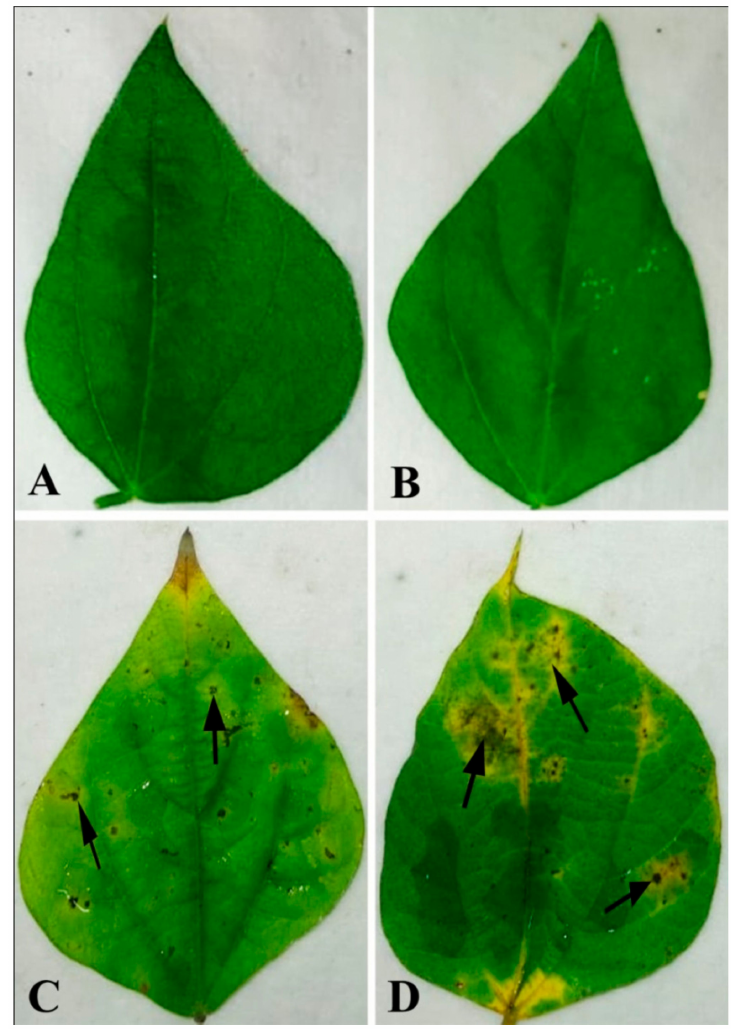
Figure 1. Pathogenicity test on bean leaf. Water-treated control showing no symptoms after ( a ) 2 dai and ( b ) 4 dai. Leaves treated with conidial suspension showing infection zones after ( c ) 2 dai and ( d ) 4 dai. Arrows indicate the site of pathogen infection. Note: dai = days after